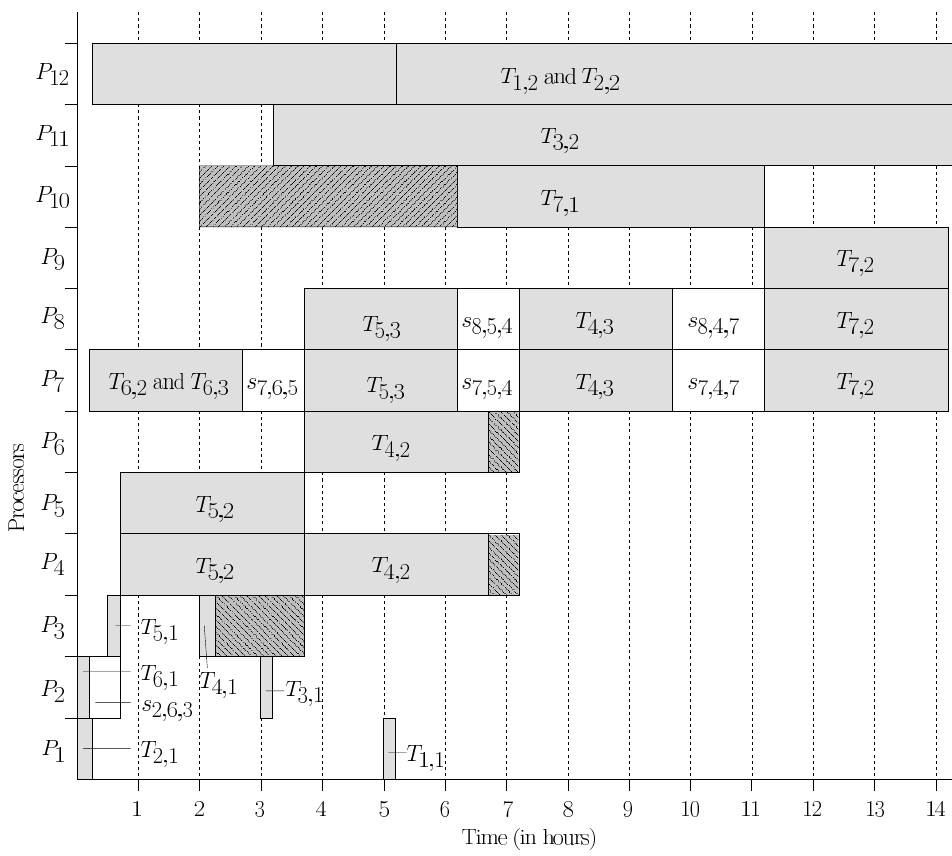
Figure 2: Gantt-chart representation of the candidate solution to the active scheduling problem obtained by applying the cellar packing algorithm to the initial solution for a small hypothetical cellar and for the seven jobs in Table 1, resulting in an upper bound of 14.2 hours on the completion time. The setup time required on processor P i between jobs J j